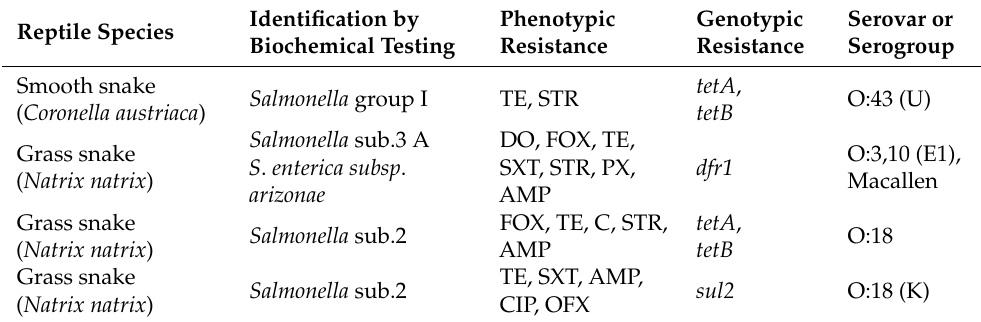
Table 5. Characteristics of Salmonella isolated from wild reptiles.